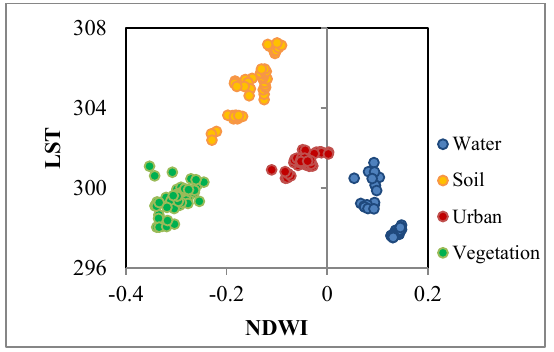
Figure10. LST-NDWI relation with land cover Waterbodies shows positive values of NDWI with lower LST whereas other land covers shows negative